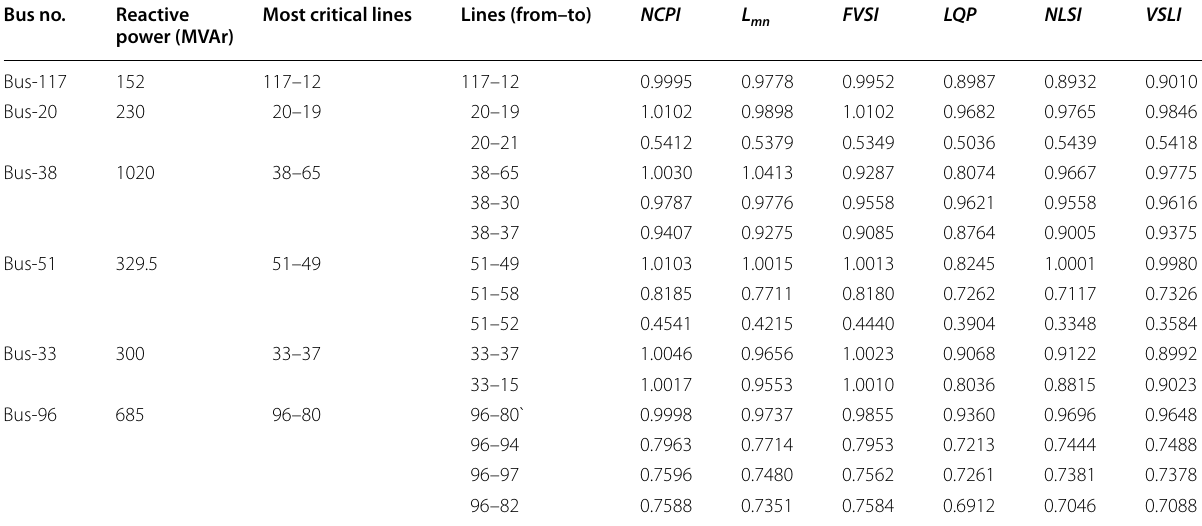
Table 7 The line stability indices for the IEEE 118-bus system under heavy reactive power load Bus